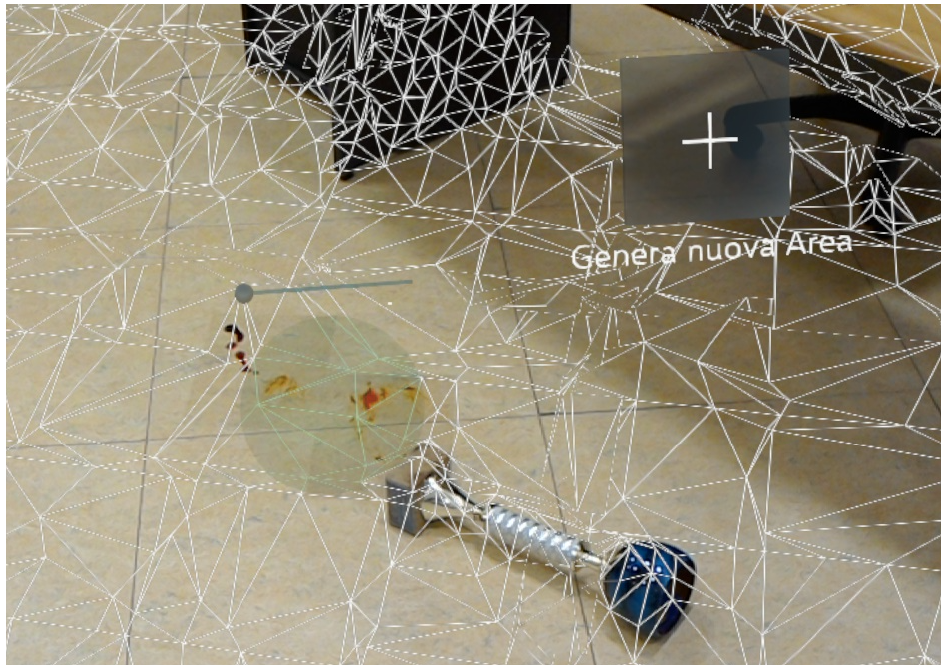
Figure 3. Example of the green spherical area for selecting a trace to be identified (in the scenario creation user mode). The Genera Nuova Area label stands for Generate evidence placeholder .